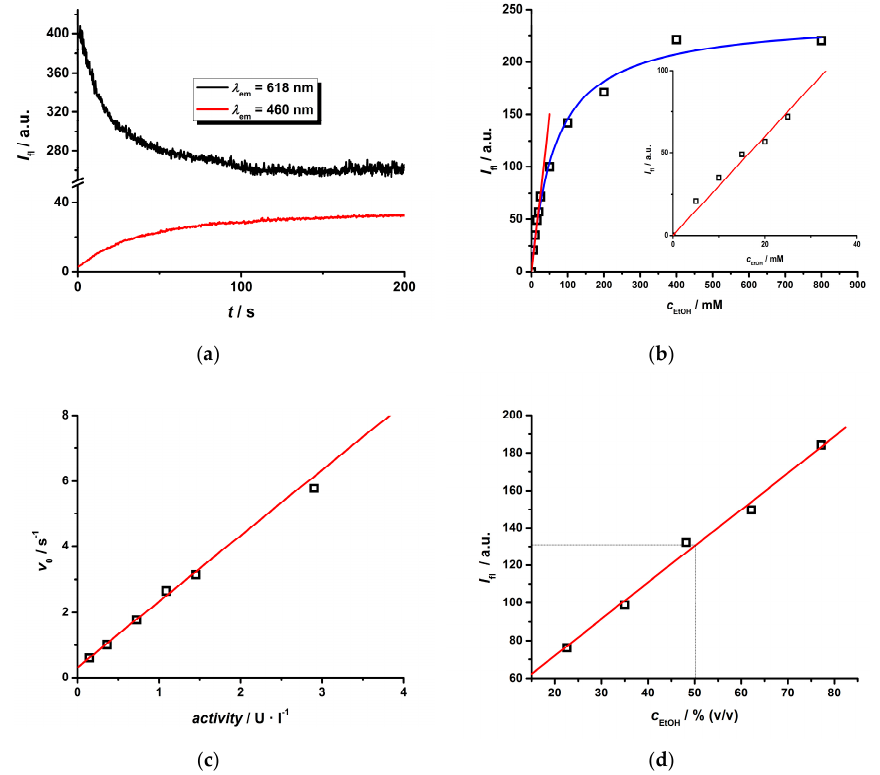
Figure 7. The enzymatic reaction of ethanol transformation catalyzed by the ADH enzyme (pH = 8.0 (20 mM HEPES), c EuL = 0.1 mM, c IQCA = 0.15 mM, c NAD = 0.1 mM). ( a ) an example of the time trace of fluorescence intensity for the enzymatic reaction under the same experimental conditions ( c EtOH = 0.1 M). ( b ) the dependence of fluorescence intensity change of the Eu(III) complex on ethanol substrate measured at the end of enzymatic reaction (ADH_activity = 1.5 U.L − 1 ). ( c ) the dependence of the initial rate of the enzymatic reaction on enzyme ADH activity ( c EtOH = 0.1 M). The initial